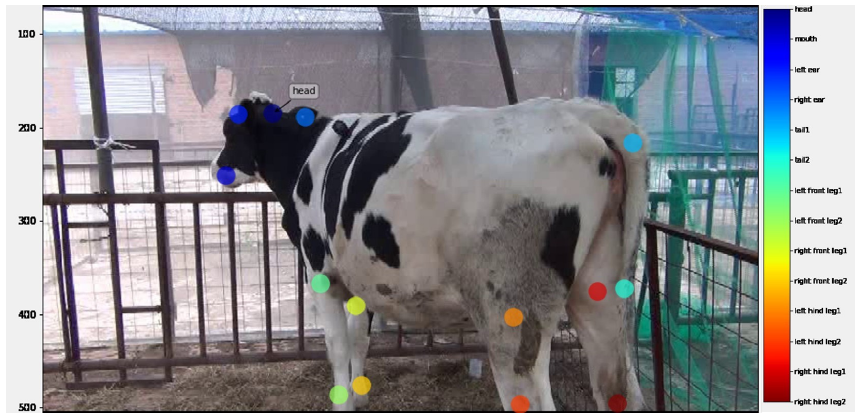
Figure 1. Feature points of key areas of protective behavior in dairy cows. Different colors were used to mark different characteristic points, including the head, limbs, and tail. These body parts are the key points regarding the cow’s protective behavior.